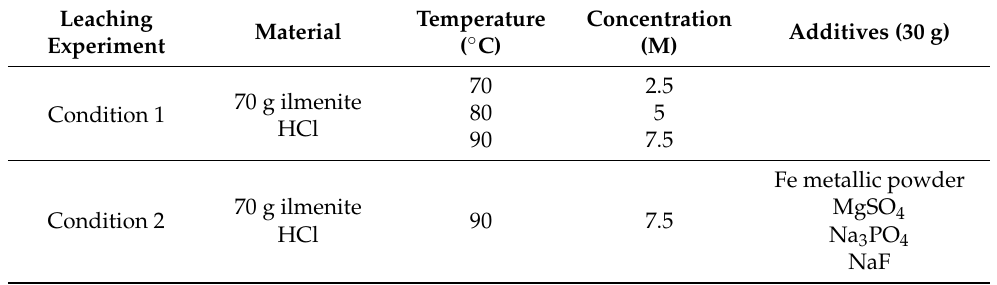
Table 1. Experimental leaching conditions.